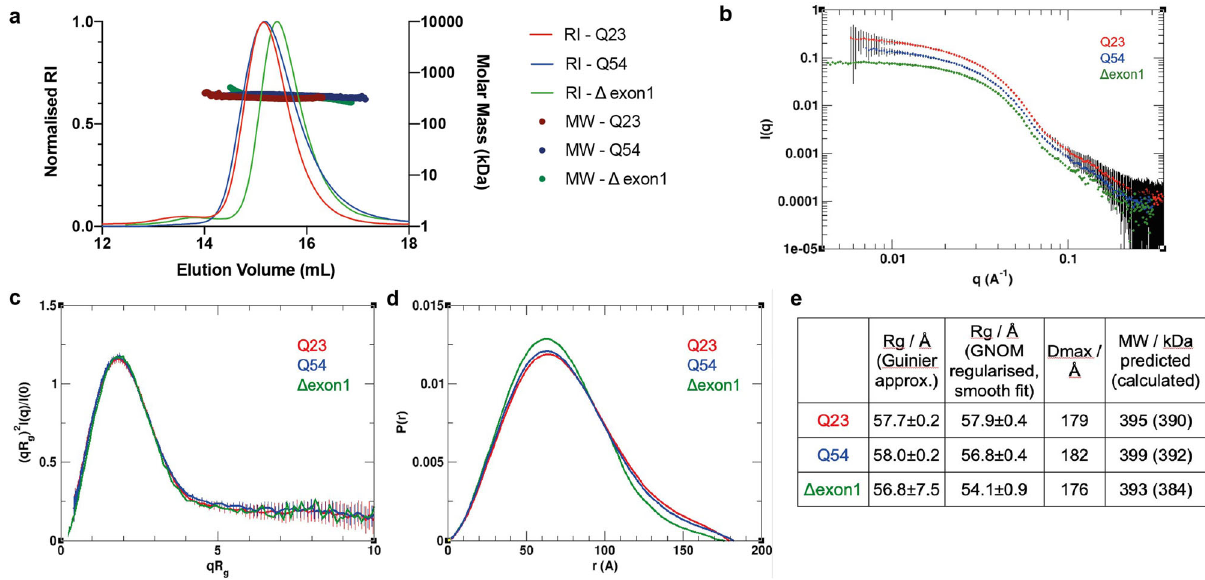
Fig. 6 Polyglutamine expansion or deletion of exon 1 has modest effects on the full-length HTT-HAP40 SAXS pro fi le. a SEC-MALS analysis of HTT- HAP40 samples Q23 (red), Q54 (blue) and Δ exon 1 (green). b Experimental SAXS data. c R g -based (dimensionless) Kratky plots of experimental SAXS data for HTT-HAP40 Q23 (red), Q54 (blue) and Δ exon 1 (green). d Normalised pair distance distribution function P ( r ) calculated from experimental SAXS data with GNOM for HTT-HAP40 samples. e SAXS parameters for data validation and interpretation including radius of gyration ( R g ) calculated using Guinier fi t in the q range 0.015 < q < 0.025Å − 1 , radius of gyration calculated using GNOM, maximum distance between atoms calculated using GNOM and the molecular mass estimated using SAXSMoW with expected masses from the respective construct sequences shown in the